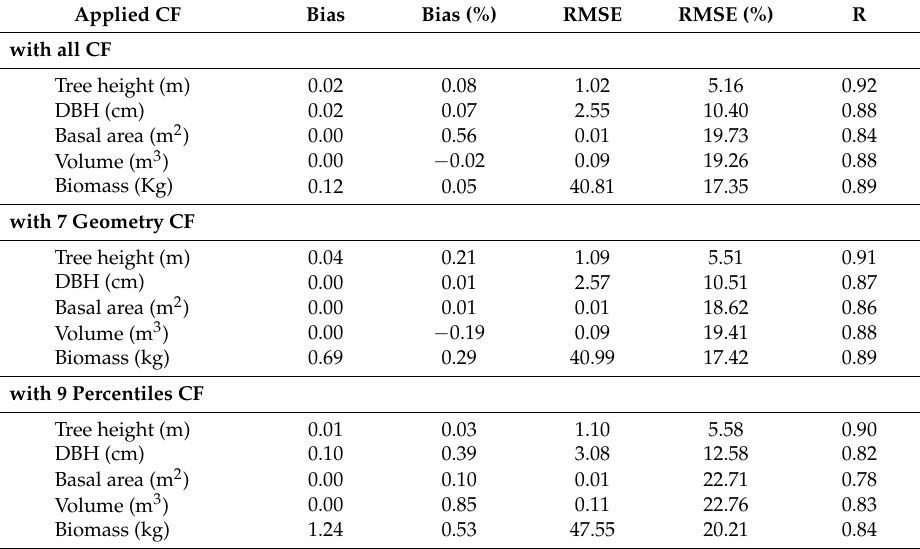
Table 4. Accuracy of tree attribute estimation based on different combinations of crown features (CF) using random forest (RF) regression.